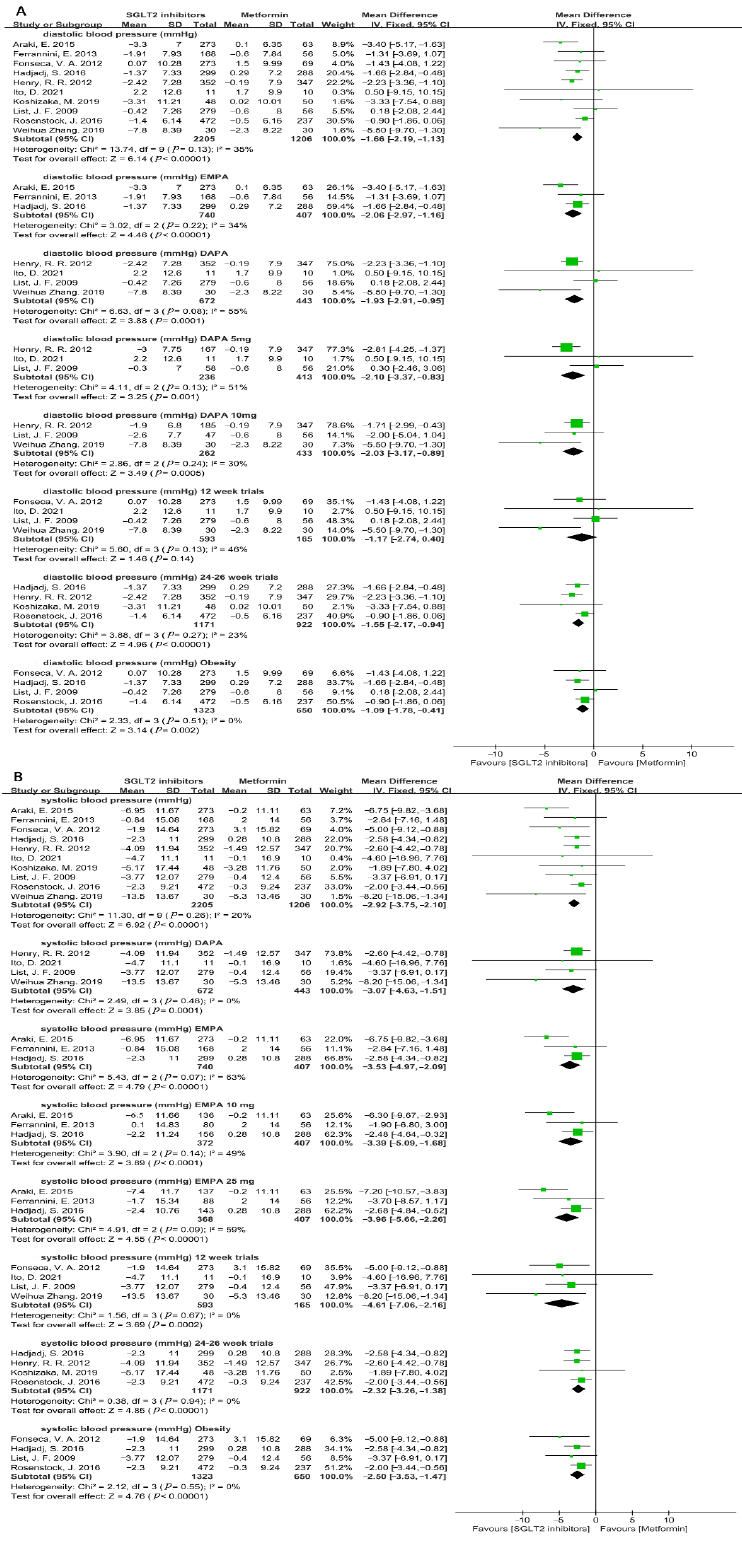
Figure 14. ( A ) . Weightedmeandifferenceinchangeindiastolicbloodpressure(mmHg)frombaselinefrom SGLT2i compared with metformin [20,22–26,28,29,31,32]. ( B ). Weighted mean difference in change in sys- tolic blood pressure (mmHg) from baseline from SGLT2i compared with metformin [20,22–26,28,29,31,32]. DAPA = dapagliflozin, EMPA = empagliflozin. 12 weeks trials = SGLT2i used 12 weeks, 24–26 weeks trials = SGLT2i used 24–26 weeks. Obesity = SGLT2i used in obese